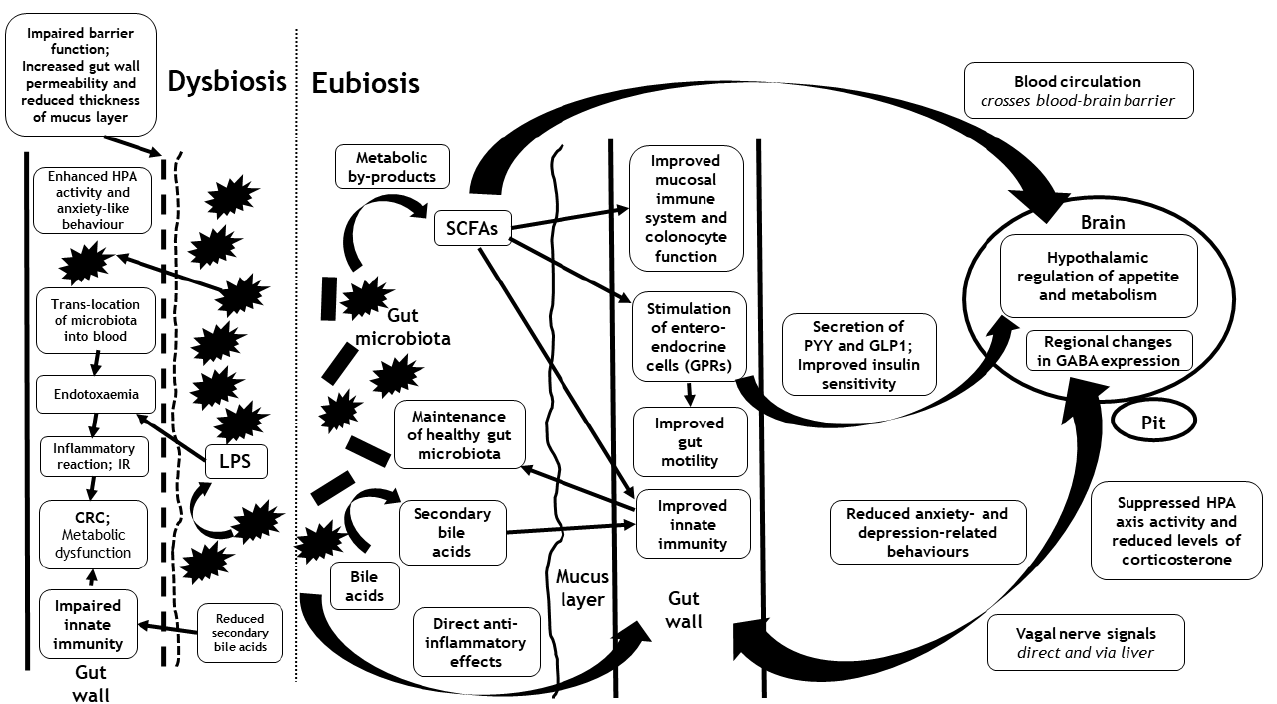
Figure 1. Outline of the major proposed pathways that link the gut microbiota with the brain during eubiosis and dysbiosis, including the hypothalamus–pituitary–adrenal axis (HPA) and autonomic, neuro-humeral, entero-endocrine and immunomodulatory pathways. Interactions may occur directly through translocation of the gut microbiota or their cell walls (endotoxaemia) and/or through the release and absorption of the metabolic by-products of the gut microbiota (such as short chain fatty acids (SCFAs)). Although the interactions between the gut microbiota (and their metabolic by-products) and the brain are mediated via similar pathways in eubiosis and dysbiosis, their effects are opposed. Eubiosis associates with the suppression of the HPA axis and the alleviation of anxiety, whereas dysbiosis associates with enhancement of the HPA axis and anxiety-like behaviour. CRC = colorectal cancer; GABA = gamma-amino butyric acid; GLP1 = glucagon-like peptide-1; GPRs = G protein-coupled receptors; HPA = Hypothalamus-pituitary adrenal; IR = Insulin resistance; LPS = lipopolysaccharide; Pit = pituitary; PYY = peptide YY; SCFA = Short chain fatty acid.